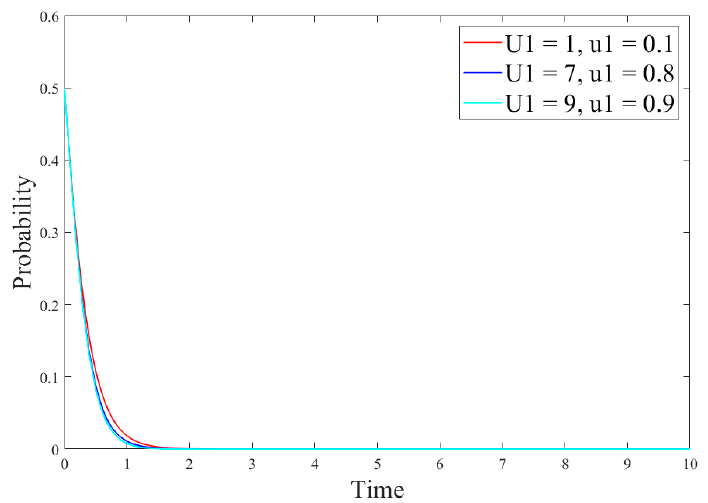
Figure 11. Evolution results of the government’s strategy.